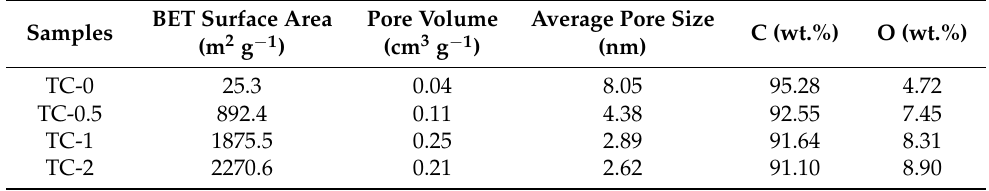
Figure 4. ( a ) Nitrogen − adsorption/desorption isotherms at 77 K, and ( b ) Barrett–Joyner–Halender (BJH) pore − size distributions of four samples. Table 2. Textural characteristics and the content of elements of